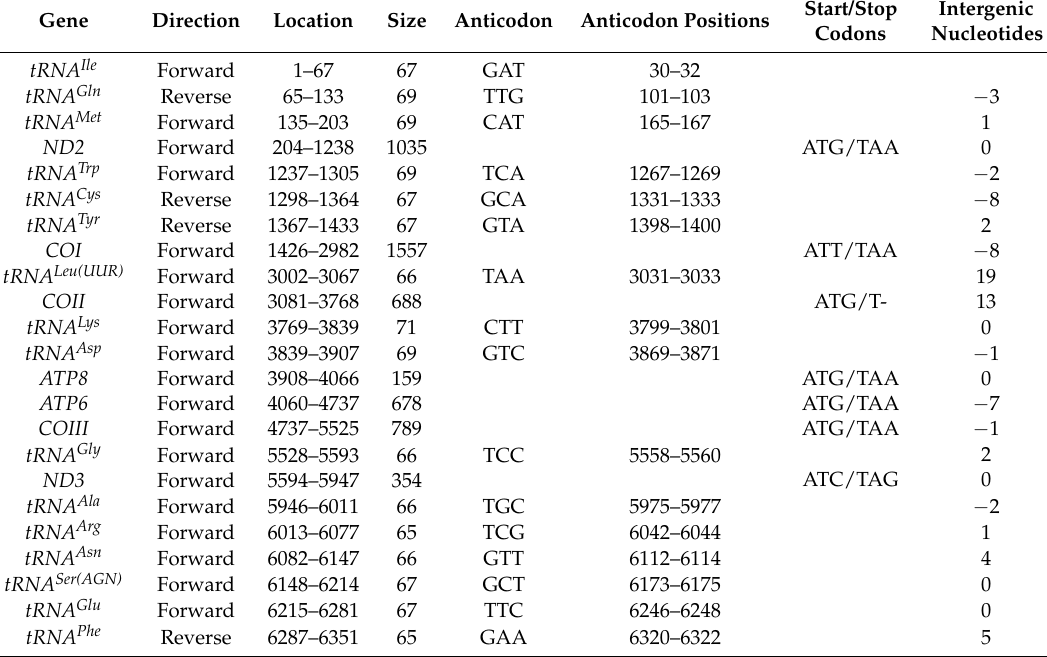
Table 2. Organization of the S. teleckojensis mitochondrial